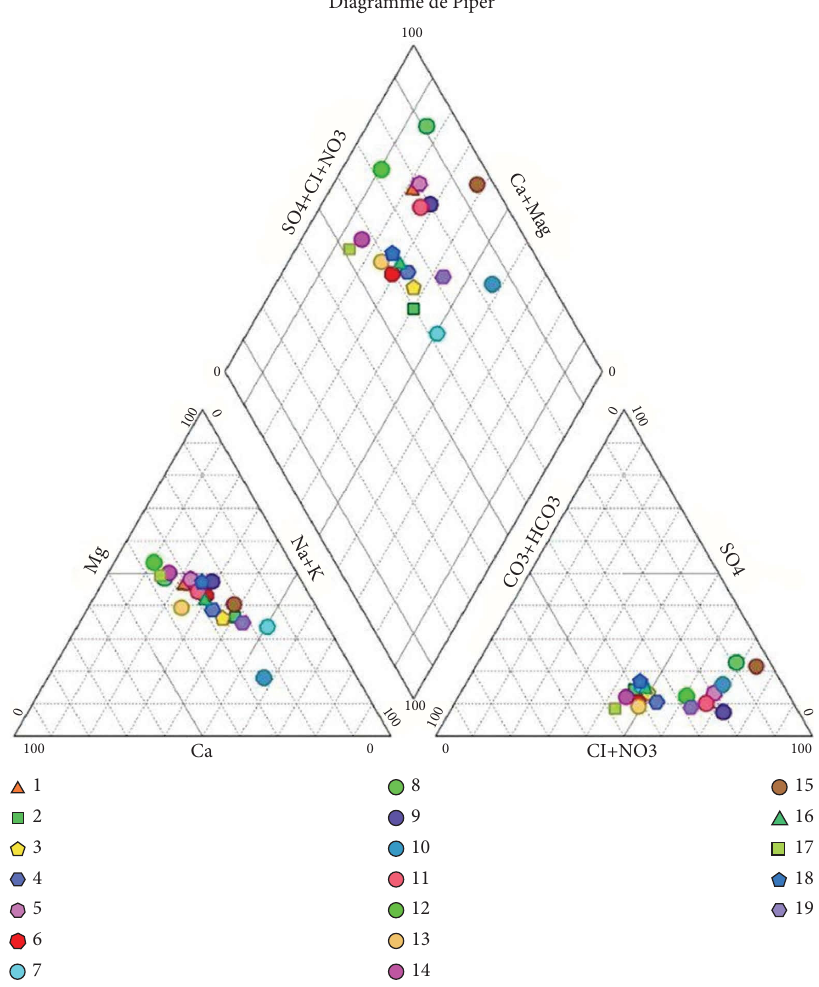
Figure 9: Piper diagram of Angads groundwater in September